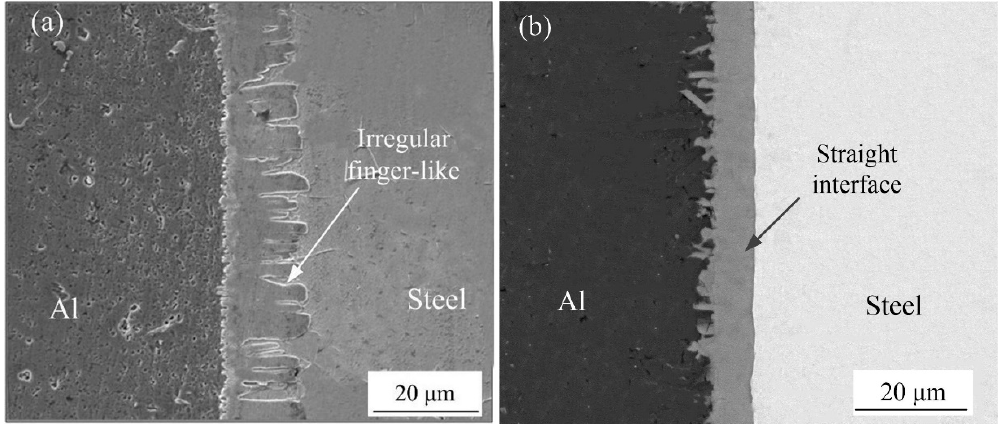
Figure 2. Interface morphology: ( a ) without adding Si element and ( b ) adding Si element.